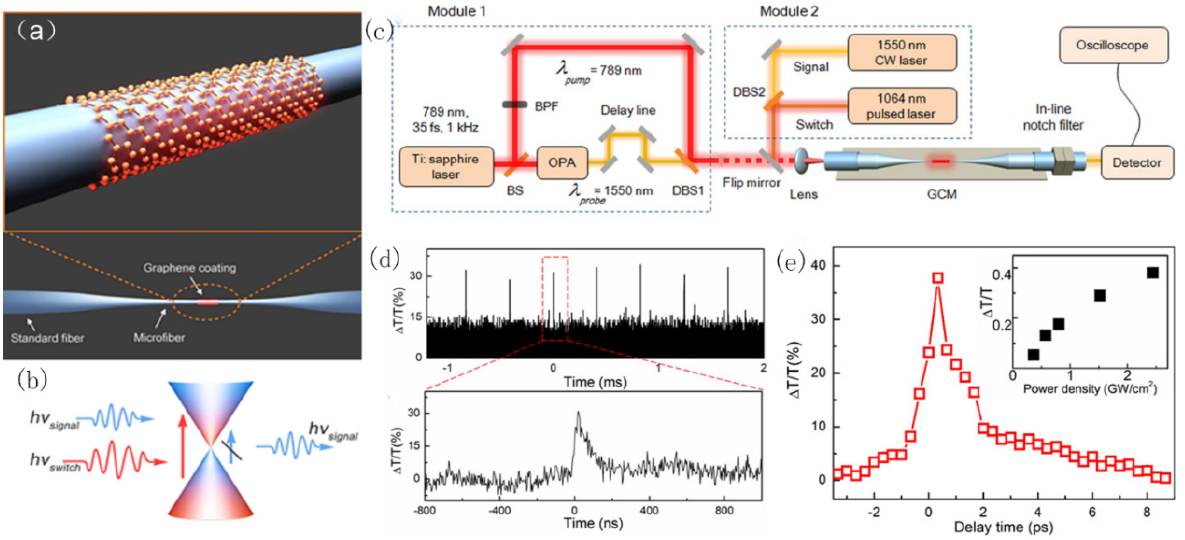
Figure 9. All-optical modulator based on saturable absorption modulation. ( a ) The schematic diagram of a tapered microfiber that is wrapped by graphene. ( b ) The interaction mechanism between light and graphene. Strong switch light stops the absorption of signal light by graphene, leading to intensity modulation of signal light. ( c ) Experimental setup. Module 1: pump-probe setup for measuring the response time of graphene. Module 2: all-optical modulation setup. ( d ) Temporal waveforms of modulated signal light. ( e ) The measured differential transmittance by pump-probe, showing the response time of ~2.2 ps. Reprinted with permission from Ref. [28]. Copyright 2014, ACS Publications.